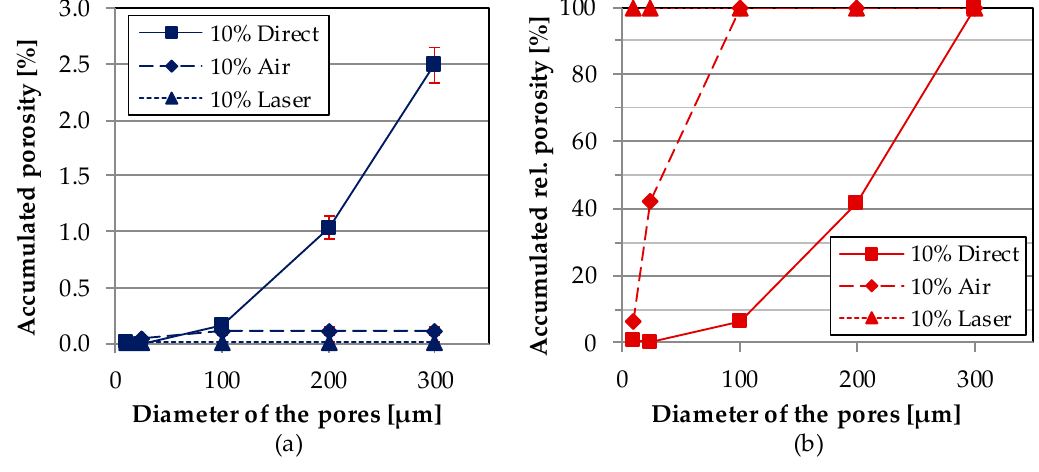
Figure 7. Accumulated porosity with respect to pore size in ( a ) total; ( b ) relative terms.